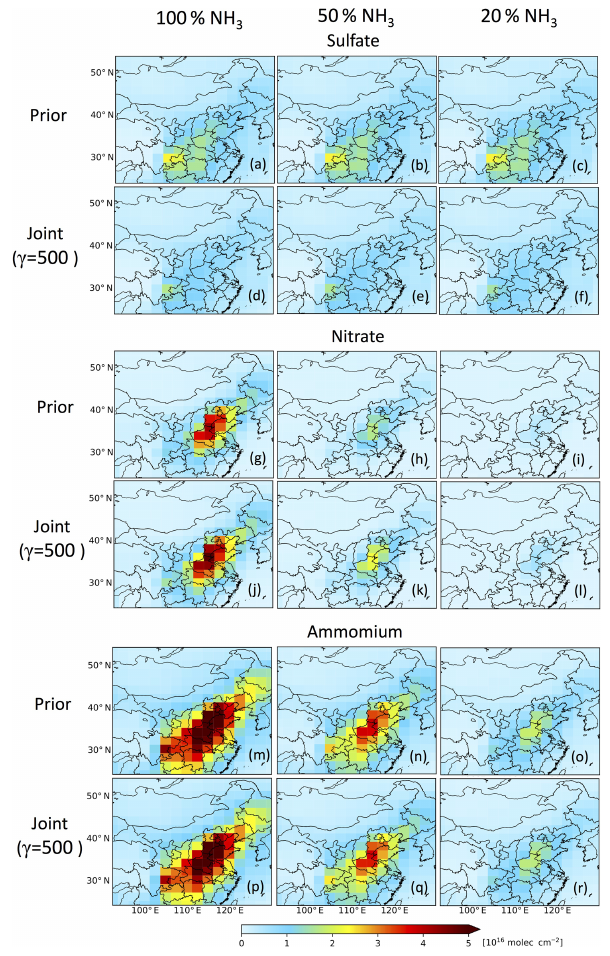
Figure 12. Sulfate, nitrate, and ammonium column loadings in dif- ferent scenarios. Panels (a) – (c) show prior sulfate at 100%, 50%, and 20% NH 3 emissions, respectively. Panels (d) – (f) show pos- terior sulfate from joint inversions ( γ = 500) at 100%, 50%, and 20% NH 3 emissions, respectively. Panels (g–i) and (m–r) are sim- ilar to (a–f) but for nitrate and ammonium,